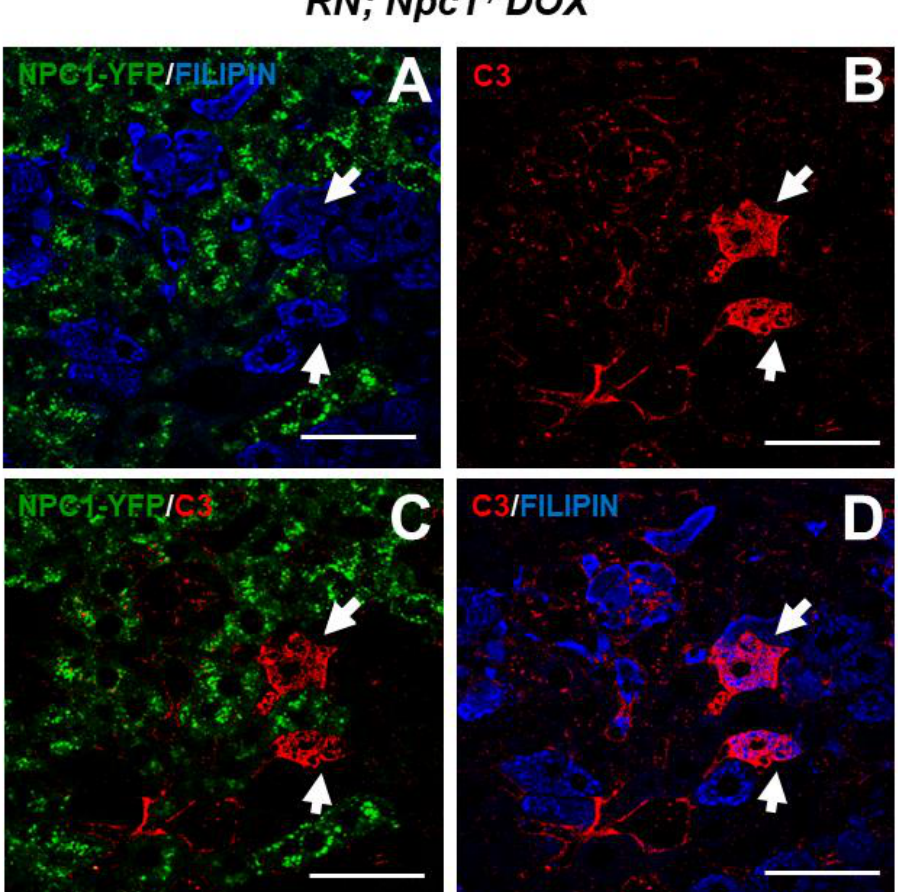
Figure 2. Reversible activation of the complement cascade in NPC livers. Expression of the Niemann-Pick type C1 protein fused with Yellow Fluorescent Protein (NPC1-YFP) transgene, driven by Rosa- rtTA in R; N − (R;N) in the Npc1 −/− background, was induced with doxycycline from P28-33. ( A ) NPC1- YFP (green) and filipin staining (blue). ( B ) C3 staining (red). ( C ) Merged images showing NPC1-YFP (green) and C3 (red). ( D ) C3 (red) and filipin (blue) staining. Arrows indicate C3-labelled cells which were positive for filipin and negative for NPC1-YFP. Scale bars are 50 µm.